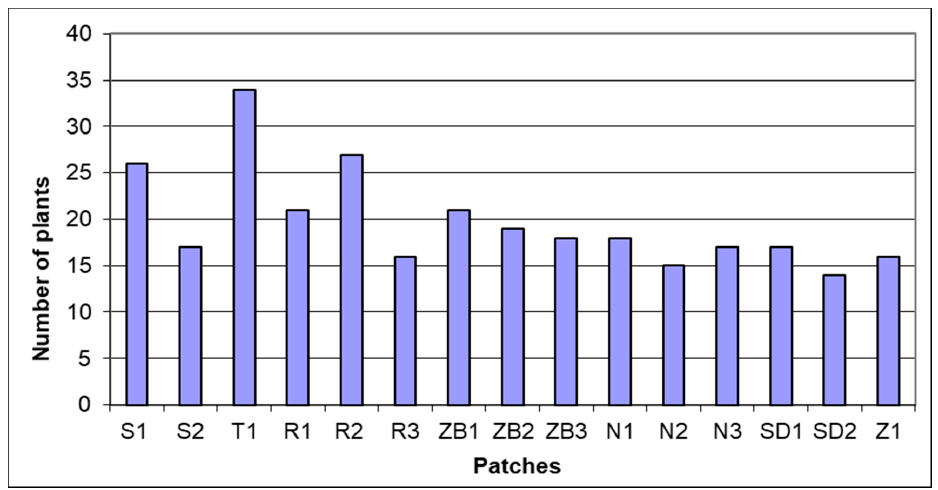
Figure 2. Number of plant species in the patches.